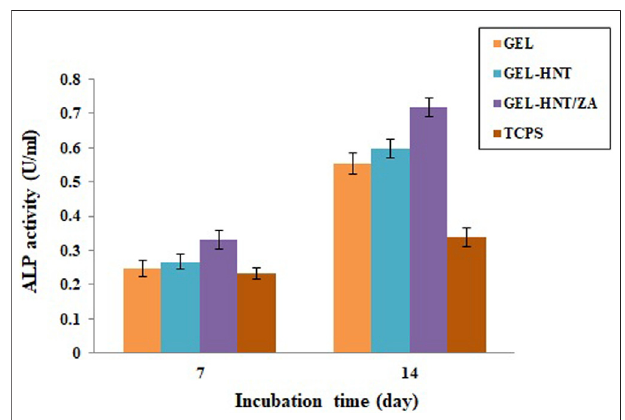
FIGURE 7 | Alkaline phosphatase (ALP) activity of (Gel, Gel-HNT and Gel-HNT/ZA) scaffolds and tissue culture polystyrene (TCPS) at 7 and 14 days, during osteogenic differentiation ( p <